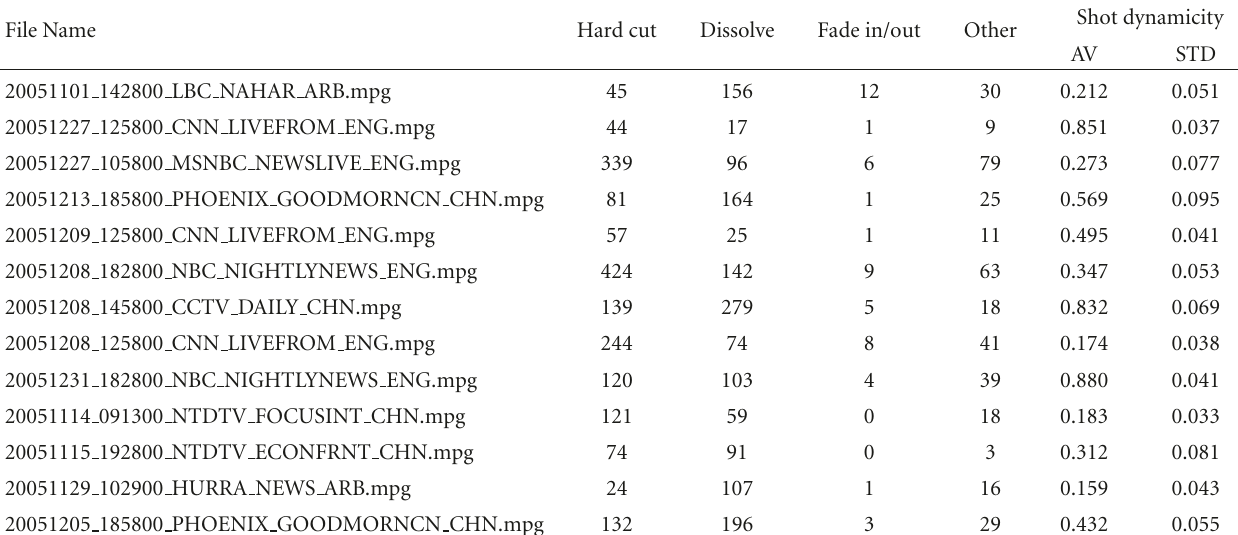
Table 1: Details of all the video of TRECVID 2006 and the average (AV) and standard derivation (STD) of their shot dynamicity.